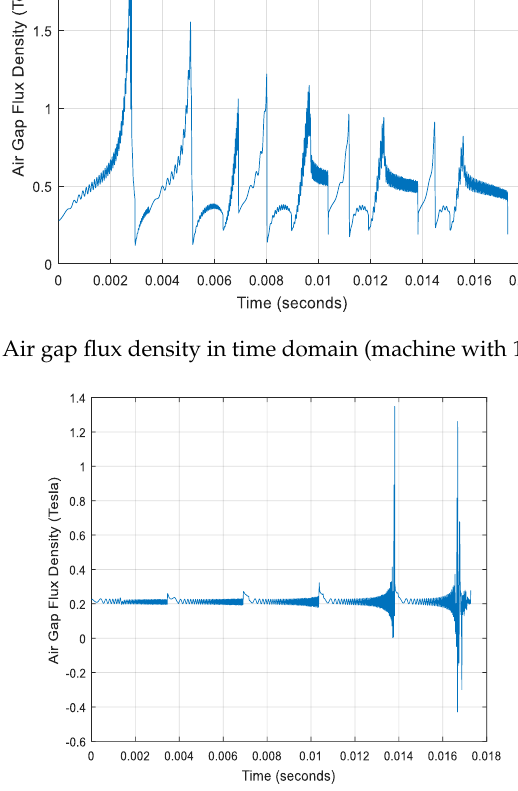
Figure 6. Air gap flux density in time domain (machine with turn-to-turn short circuit fault). Contemplating Figure 7, we can see the impact of the faults on the torque which shows that the torque is a good indicator for fault detection. The transient part of the machine ’ s operation is clearly illustrated in the graph; this is the main advantageous of the time stepping dynamic model. Comparing the graphs in Figure 7, several notes can be recorded. The blue graph is the torque in the healthy case. The red graph is the machine torque in the case of demagnetization represented by a 1 mm crack in one piece of magnet. This graph is close to that of the healthy case; however, this fault has impacted the torque with ripples clearly visualized on the graph. The average torque in this case of demagnetization is greater than the healthy case (Table 2) due to the numerical calculation where the average is calculated over the first tooth pitch that contains the peak. This increased the value of air gap flux density and, subsequently, the torque. The yellow graph is the torque of the machine when a turn-to-turn short circuit occurred in one slot of phase A. When a short circuit occurs, temperature rises in the whole machine in general and in the magnet in particular. This rise in temperature weakens the magnet, its flux density decreases; the cause is the high dependence of the magnet’s electromagnetic performance on the operating temperature . Accordingly, the torque decreases, being directly proportional to the air gap flux density. This torque will continue decreasing as the number of short circuited turns increases. We mention that in other types of electrical machines, like induction machines , when a short circuit occurs in the stator’s windings, the air gap flux density may increase and the torque will increase accordingly because the intervention of the